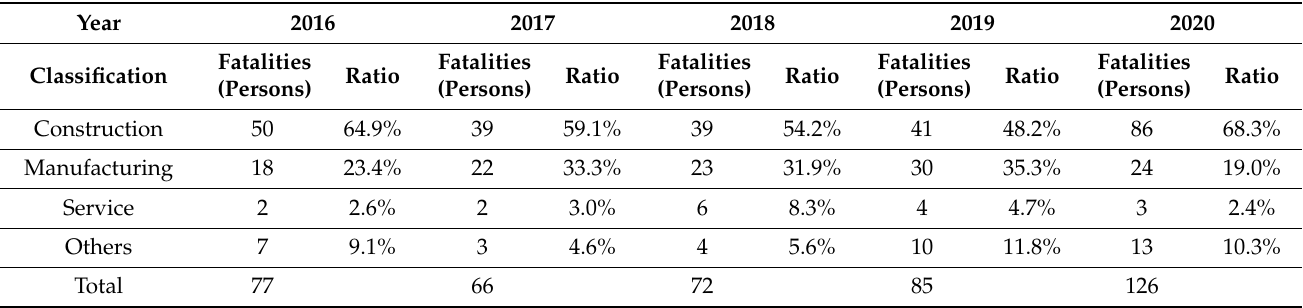
Table 6. Fatalities caused by multiple processes in the workplace based on